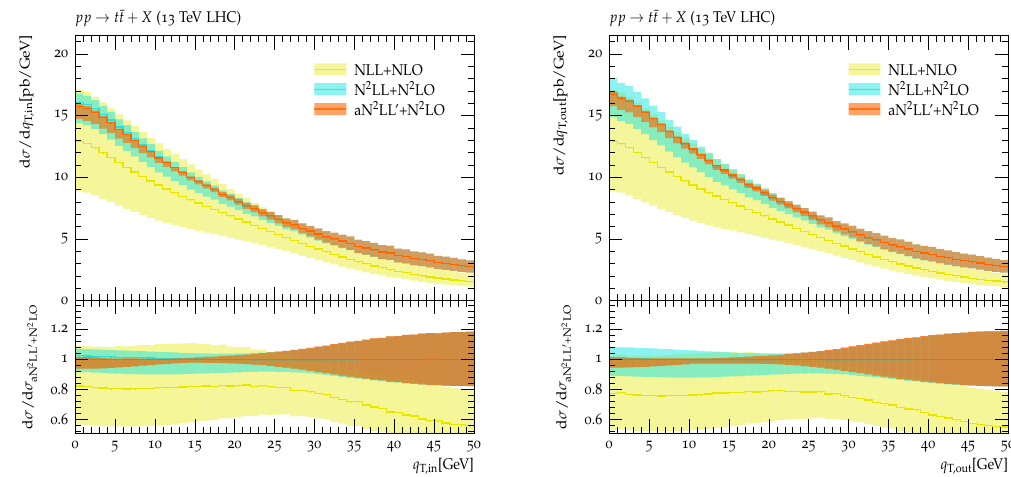
Figure 8 . The resummation improved spectra of q T , in and q T , out at NLL+NLO, N 2 LL+N 2 LO, and approximate N 2 LL 0 +N 2 LO accuracies (aN 2 LL 0 +N 2